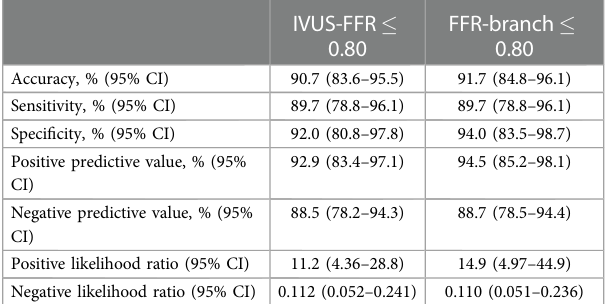
TABLE 3 Diagnostic Performance of IVUS-FFR and FFR-branch to identify invasive FFR ≤ 0.80.